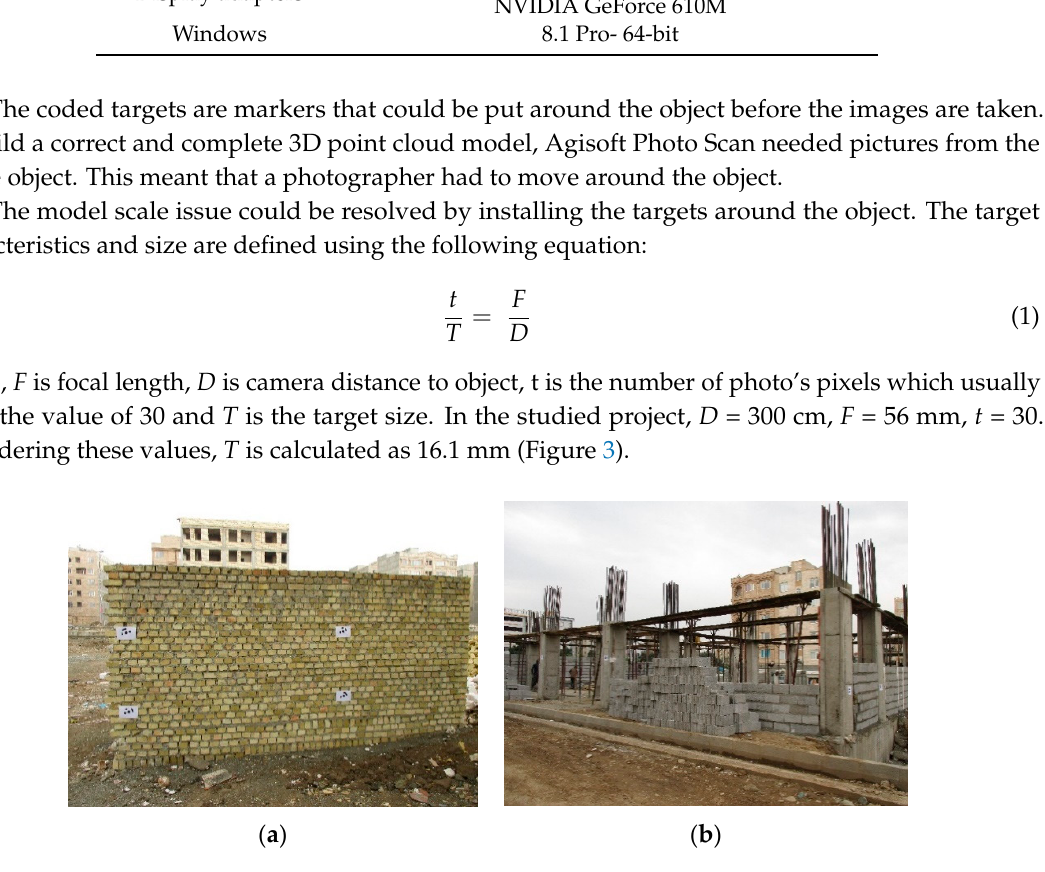
Figure 3. The coded targets in two studied projects. ( a ) The first case study ( b ) The second case study.